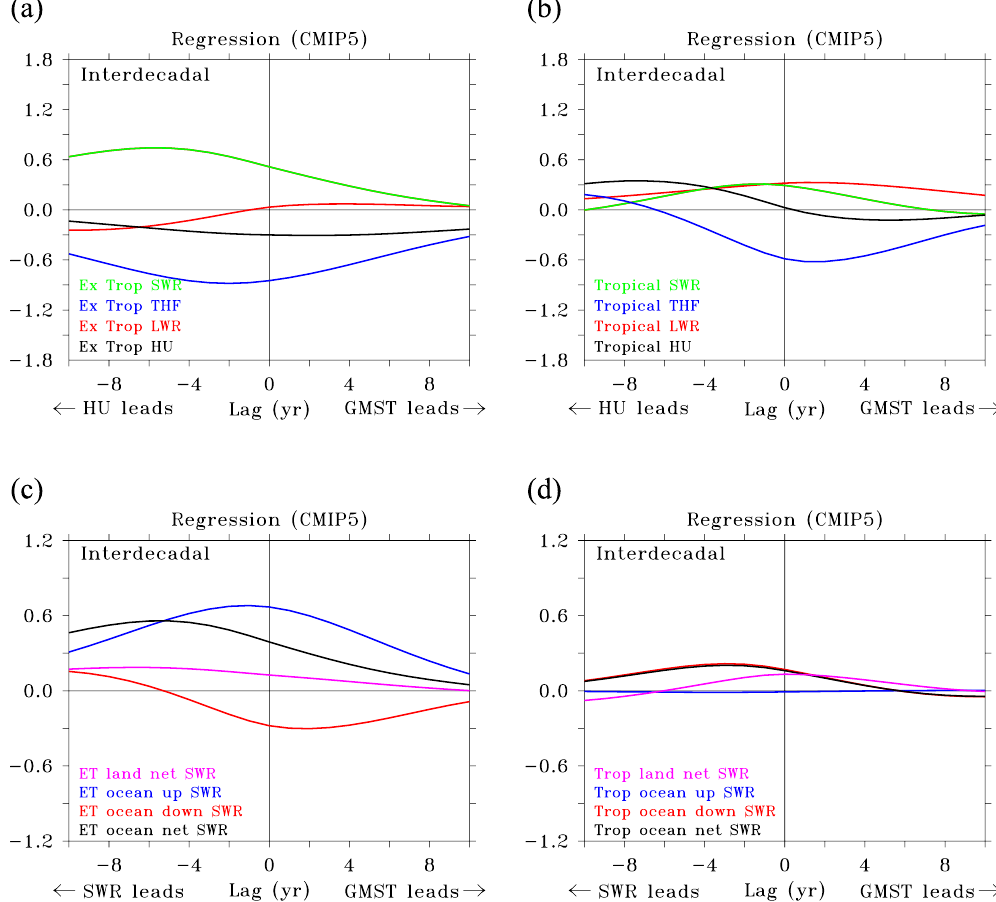
Figure 2. Relationship between GMST and HU/SWR in decadal variations for different areas. ( a – d ) Lagged regression ( a , b ) of net heat uptake HU and net shortwave radiation (SWR) ( c , d ), against GMST. ( a , b ) HU split between tropics (30°S and 30°N) and extra-tropics such that both panels sum to Fig. 1. ( c , d ) SWR split between tropics and extra-tropics, ocean and land, and upward and downward shortwave radiation such that the black and purple lines in both panels sum to the green line in Fig. 1. Regression values are in W m − 2 K − 1